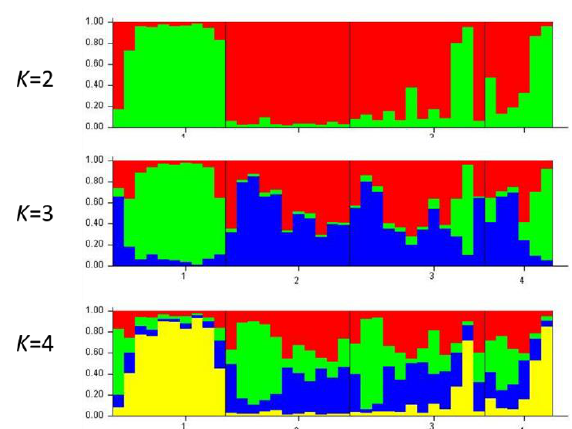
Figure 2. Graphical representation of the estimated membership coefficients for each individual obtained from the Bayesian clustering analysis of genetic structure for K = 2–4 computed from ISSR. Each individual is represented by a bar broken into K colored segments. The populations of Batna, Djelfa, Tiaret, and Bechar are indicated with the numbers 1 to 4, respectively.